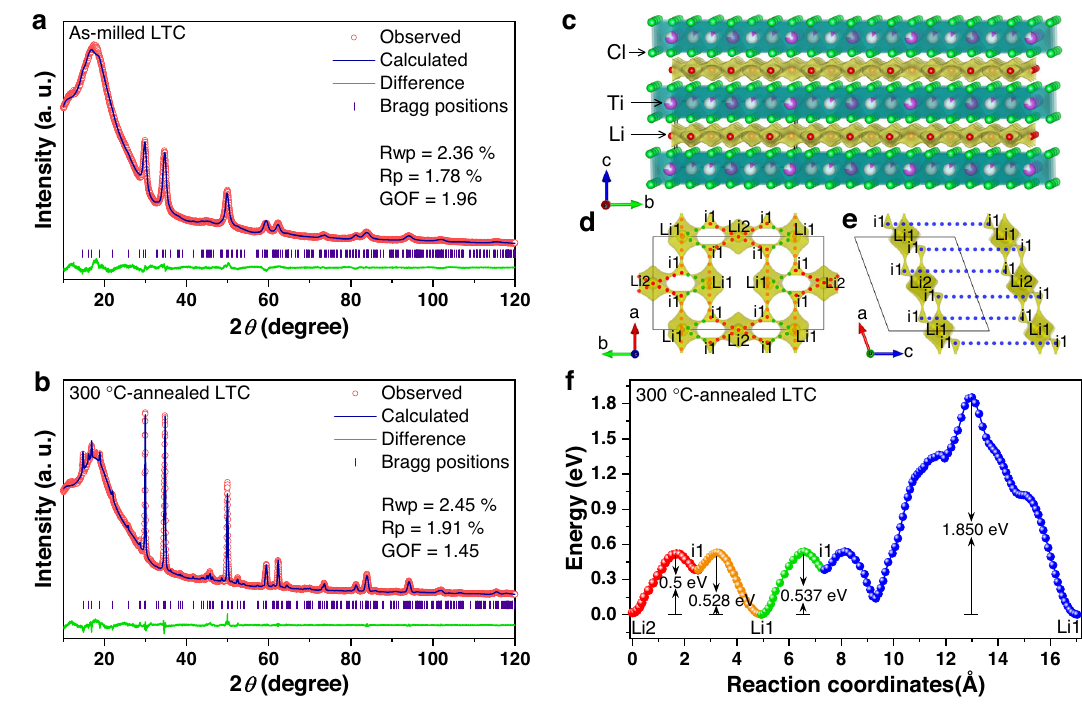
Fig.2|CrystalstructureandLi-ionmigrationbehaviorofLTC.a , b Re fi nedXRD patterns of the as-milled ( a ) and 300°C-annealed LTC ( b ). The broad hump below 30°arisesfromtheKapton fi lmsusedtopreventairexposureduringmeasurement. c ThestructuralmodelofLTCsuperimposedwiththeLi-ionpotentialmap.Boththe